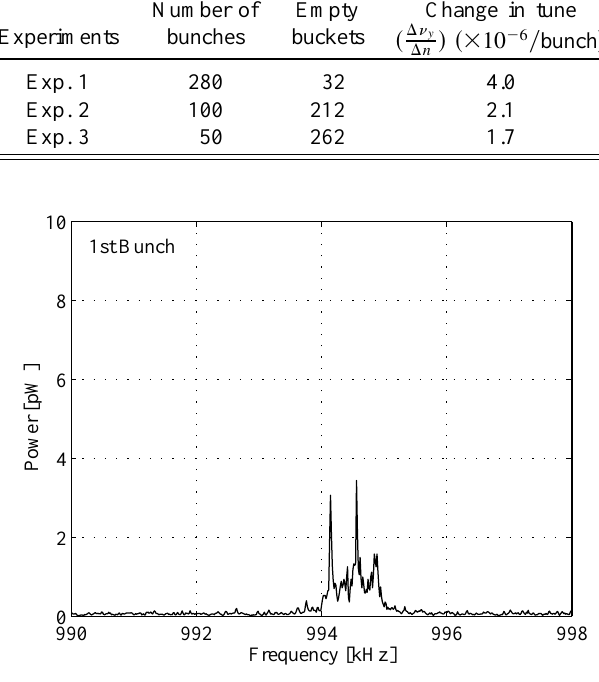
FIG. 2. Spectrum of the 1st bunch in the bunch train at f shutter 1 qf rev